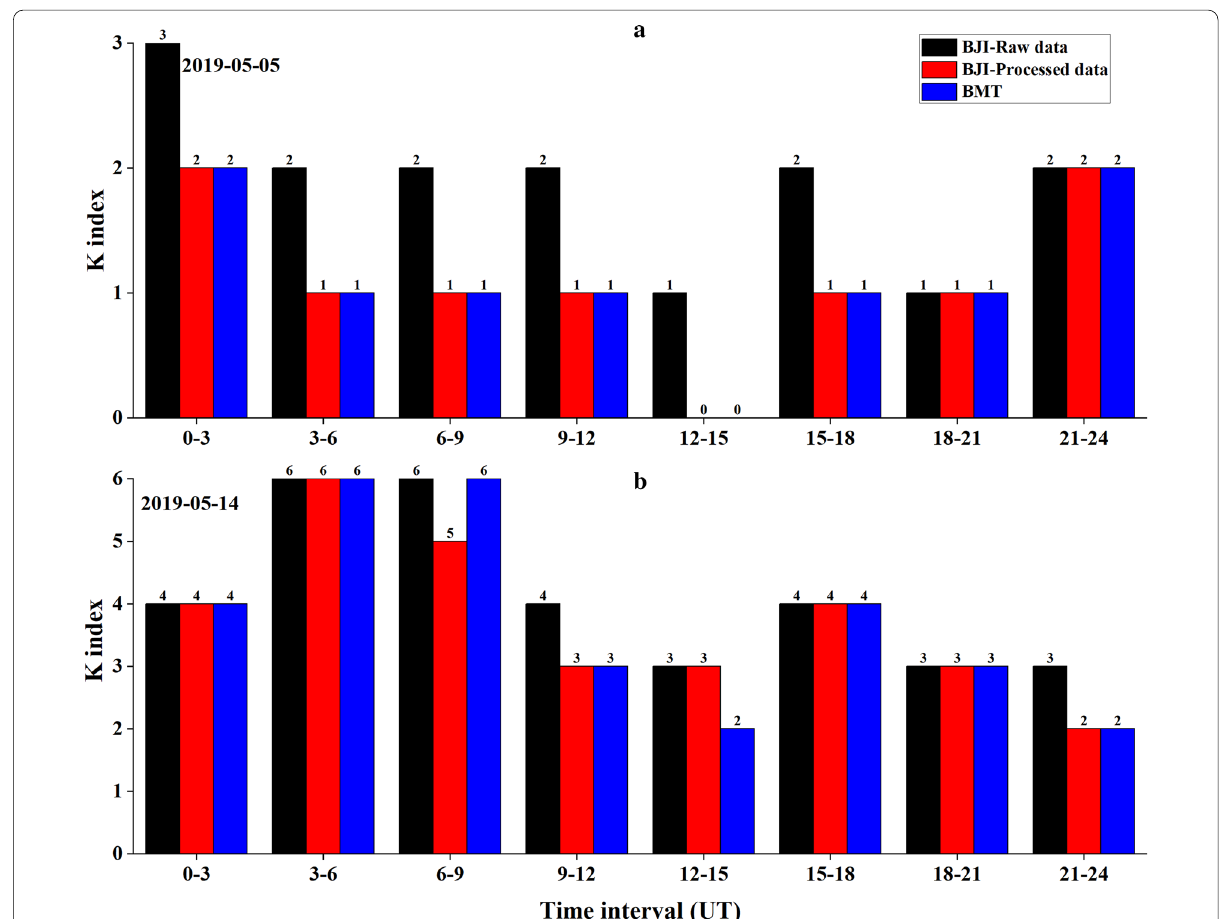
Fig. 5 K-indices for the raw data collected at BJI (black bars), the processed data by the adaptive Kalman filter (red bars), and data collected at BMT (blue